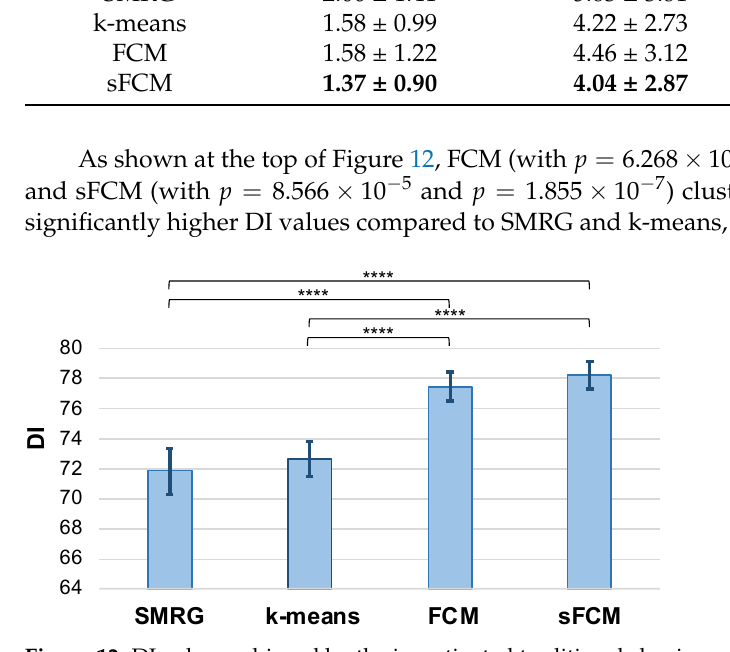
Figure 12. DI values achieved by the investigated traditional classic approaches. The bar graph and error bars denote the average value and the standard deviation DI values, respectively. The p -values, obtained from the statistical validation procedure, are shown at the top of the bars as brackets. The Wilcoxon rank-sum test for pairwise result comparison was used with the alternative hypothesis that the samples do not have equal medians of DI values. A significance level of α = 0.05 with a correction using the Bonferroni–Holm method. Notation: **** p < 0.0001.